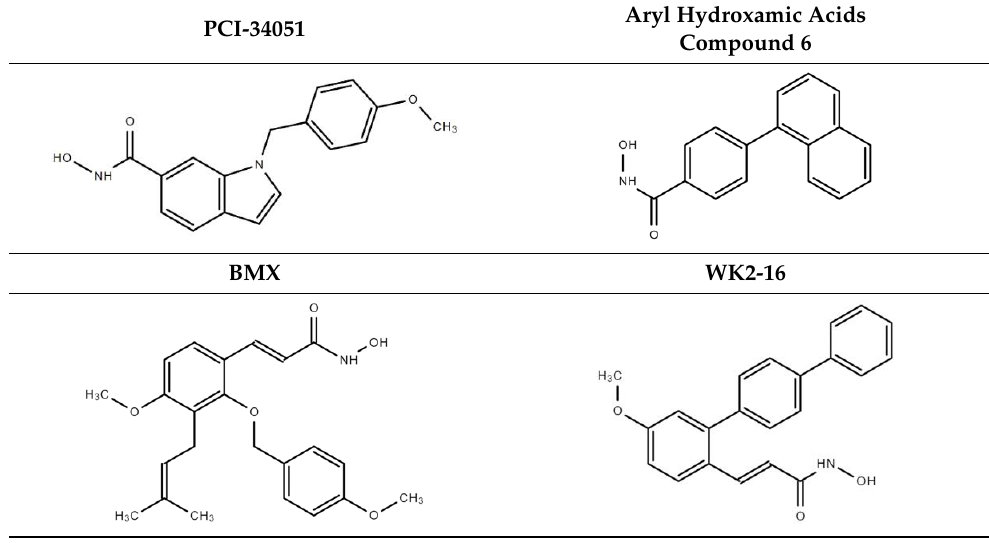
Table 3. Chemical structures of HDAC8-selective inhibitors.